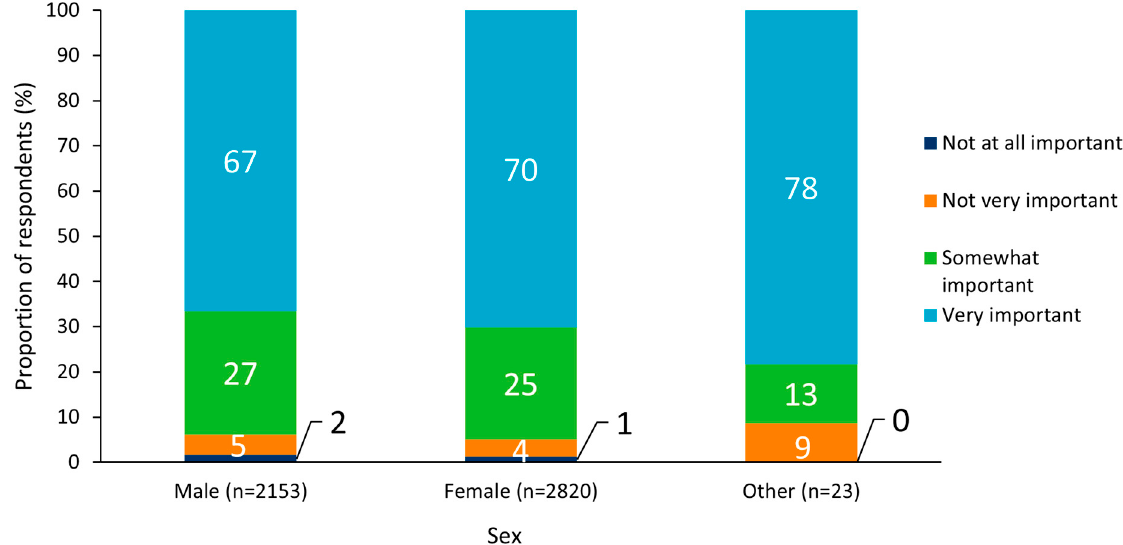
Figure 2. Perceived importance of state vaccination programs split by respondent sex.